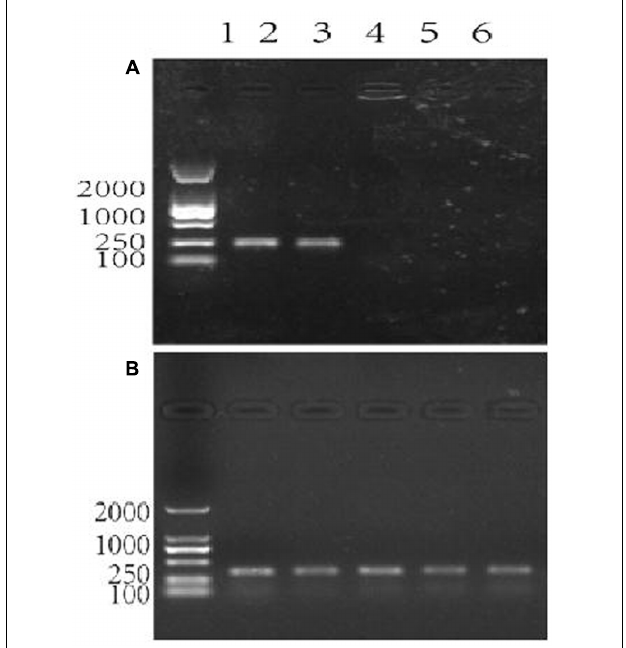
specificity of the primer pair patF-F/patF-R used for the quantification of fungi ( Penicillium expansum ) DNA. Lane 1 in (A,B) : DNA 100-2000 Marker, Lanes 2–6 in (A,B) : DNA templates. (A) The primer pair used in the PCR reactions was patF-F/patF-R. DNA from PCR reactions in which different genomic DNAs were used as the templates were: lane 2: genomic DNA